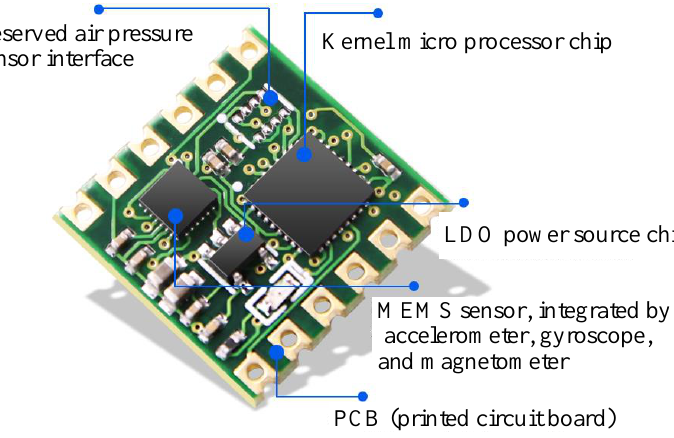
Figure 1. The integrated multi-axis IMU chip. Table 1. The key technical indexes of the multi-axis IMU chip.